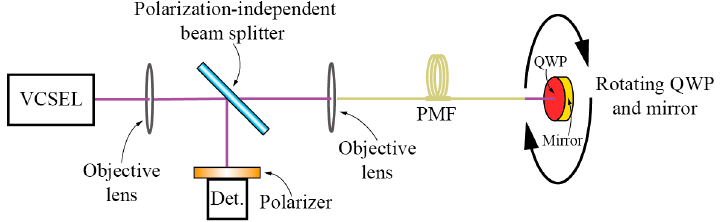
Figure 25. Rotation sensing system using a VCSEL light source with optical feedback.